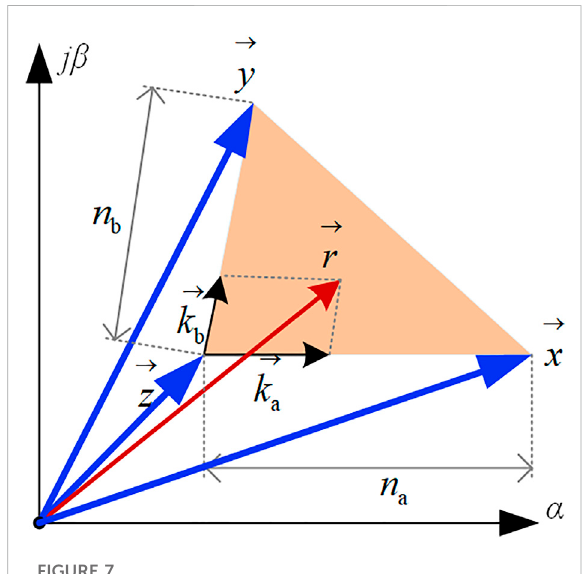
Synthesizingthetarget reference with threearbitrary vectors.